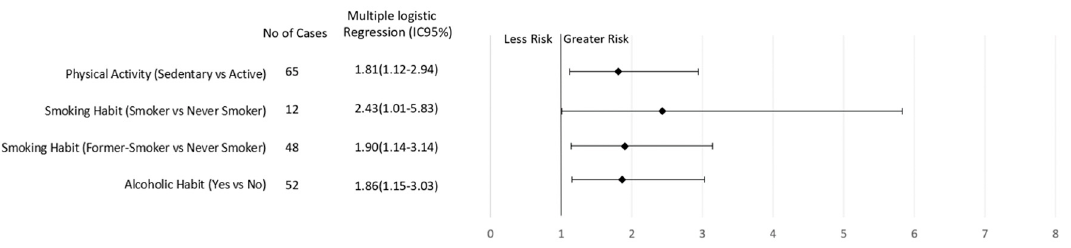
Figure 2. Association of lifestyle behavior and breast cancer risk in women according to postmenopausal status.